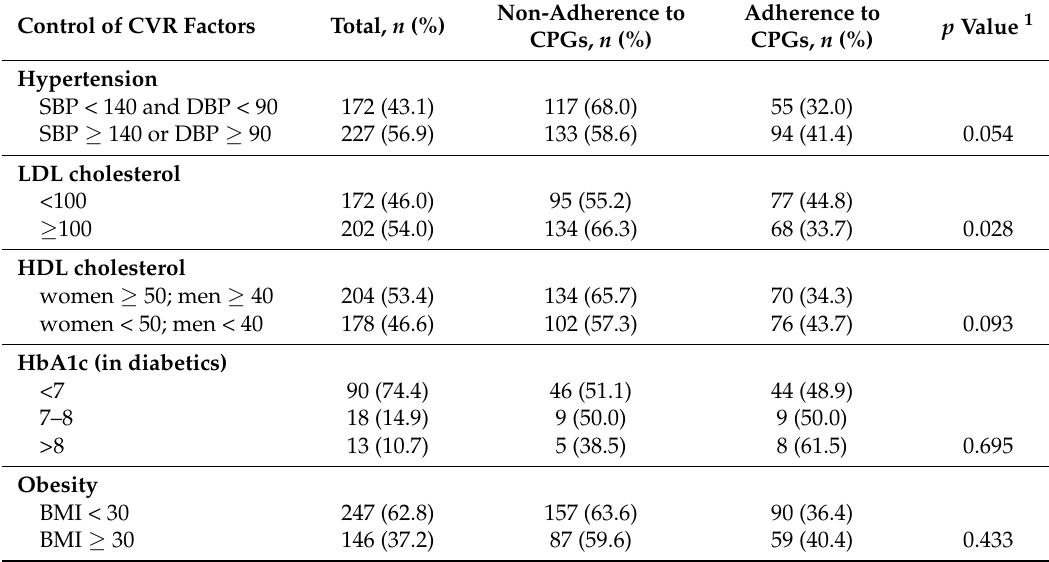
Table 6. Control of main cardiovascular risk factors, by clinician adherence to clinical practice guidelines (CPGs) for secondary prevention of cardiovascular